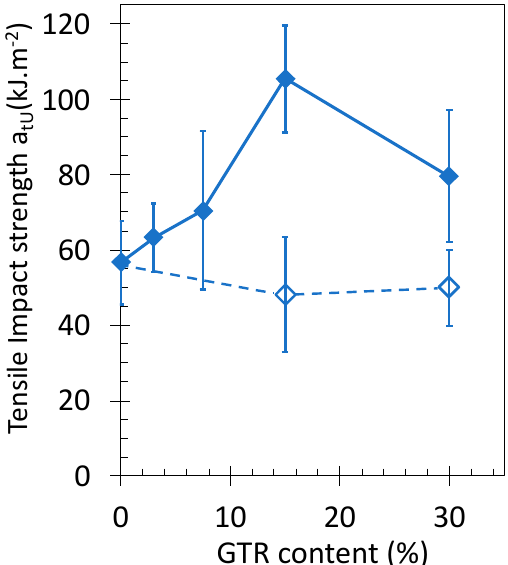
Figure 12. Tensile impact strength of neat PLA and PLA/GTR c blends in presence of 1.5 wt% of DCP (filled diamond symbols) and without DCP (unfilled diamond symbols). All blends were processed at 170 °C in presence of Irganox (0.2 wt% of total amount of material). The continuous and dotted lines are guide for the eyes for the series of data associated with blend using DCP and without DCP, respectively.